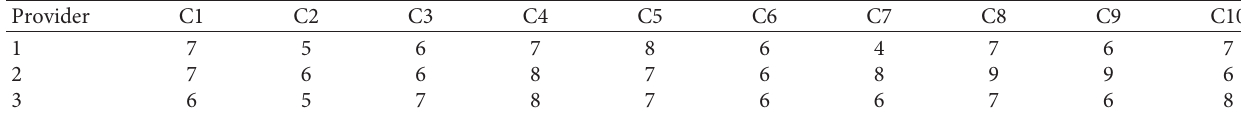
Figure 4: Network fitting comprehensive evaluation results. Table 9: The evaluation index score of LSPs.